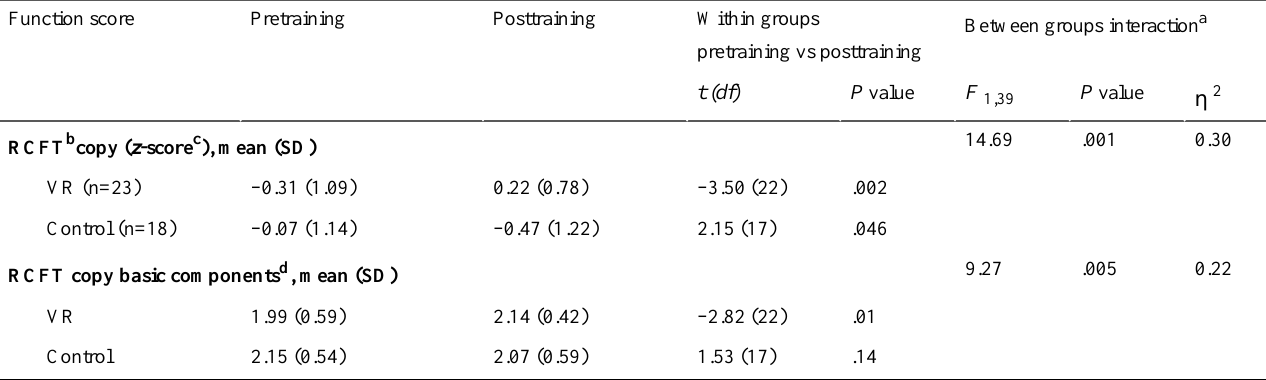
Table 2. Group comparisons of visuospatial function pre and post virtual reality (VR) cognitive